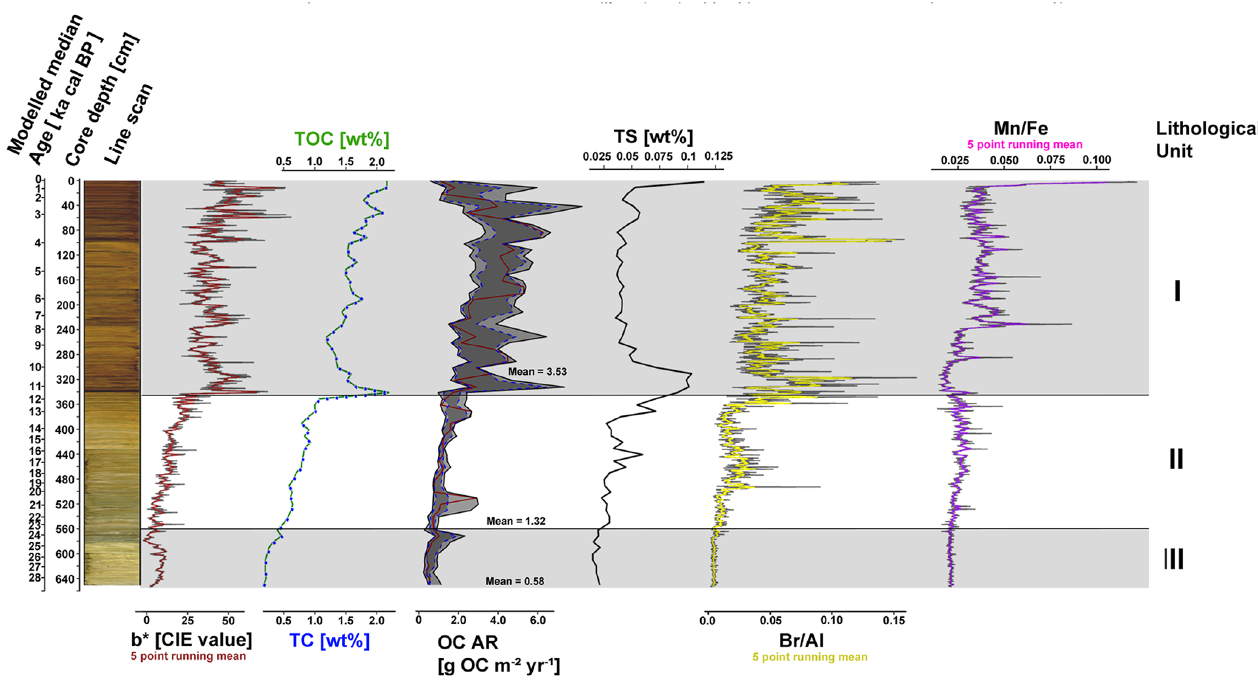
Figure 6. Biogeochemical proxies measured from samples obtained from core EN18218 (TOC, TC, TS) as well as from XRF (Br / Al, Mn / Fe) and line scanning ( b ∗ ). Average OCAR (Red line) is plotted alongside sigma uncertainty ranges (grey ribbons) synonymous with descriptions in Fig.